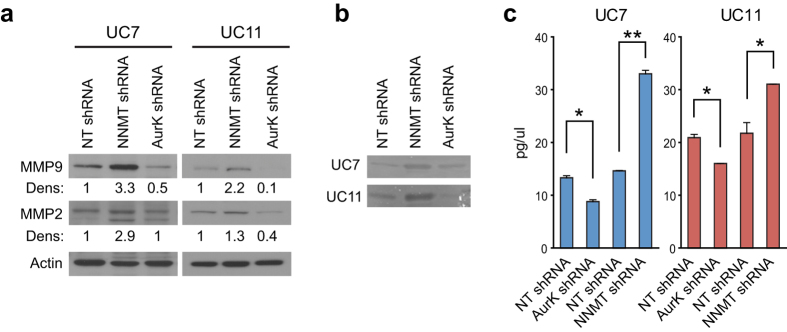
Effects of AURKA and NNMT on MMPs expression.(a) Western blots for MMP2 and MMP9 indicate an increase in both MMPs in NNMT KO cells and a decrease in both AURKA KO cells. Full length blots are shown in Supplementary Fig. S8. (b) Zymogram indicates increased levels of pro- and active forms of MMP2 in both UC7 and UC11 cell lines in NNMT KO cells, while a decrease in both pro- and active forms was observed in AURKA KO cells. Full length zymograms are shown in Supplementary Fig. S8. (c) MMP2 ELISA shows higher MMP2 levels in NNMT KO cells and lower levels in AURKA KO cells in both UC7 and UC11 cell lines (*P < 0.05, **P < 0.01).